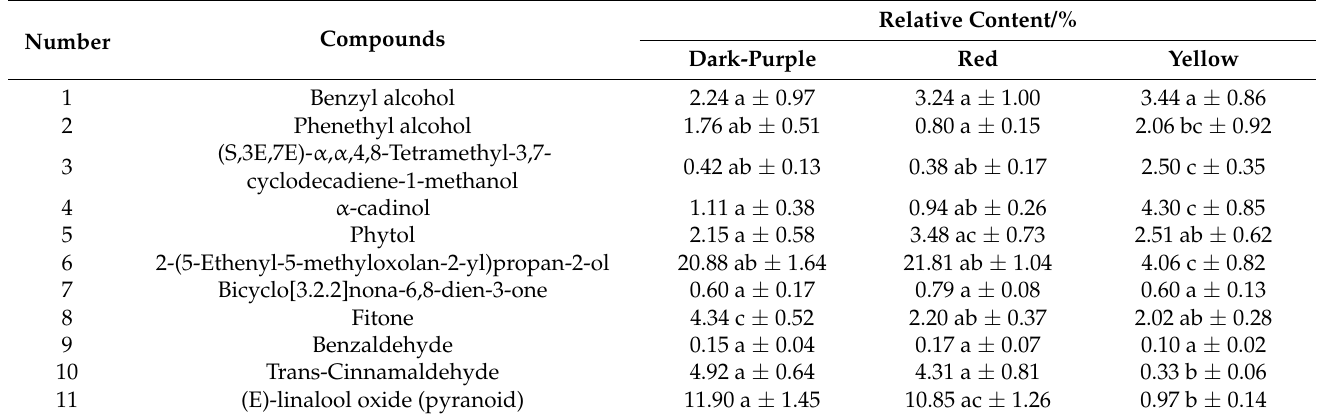
Table 1. Common compounds of essential oil for different colors of P. delavayi